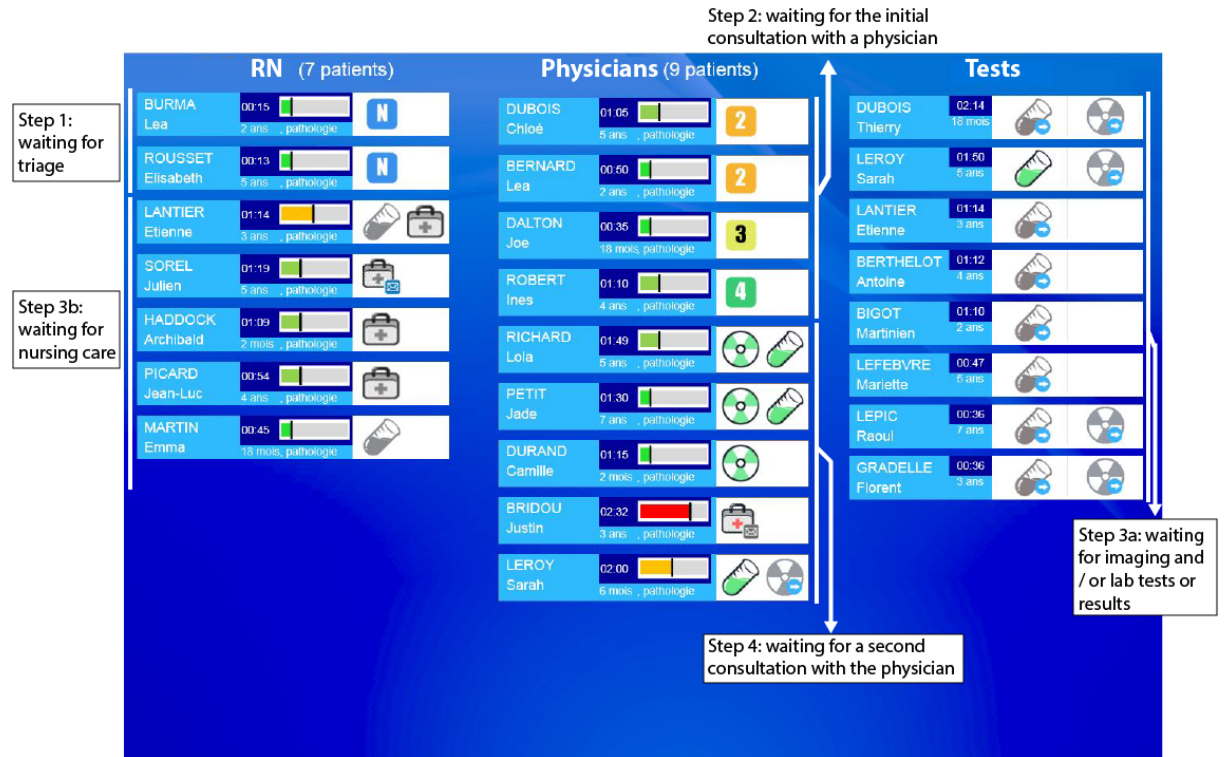
Figure 5. Mock-up patient prioritization tool’s main screen, which gives an overview of the patients and information on each patient. RN: registered nurse.